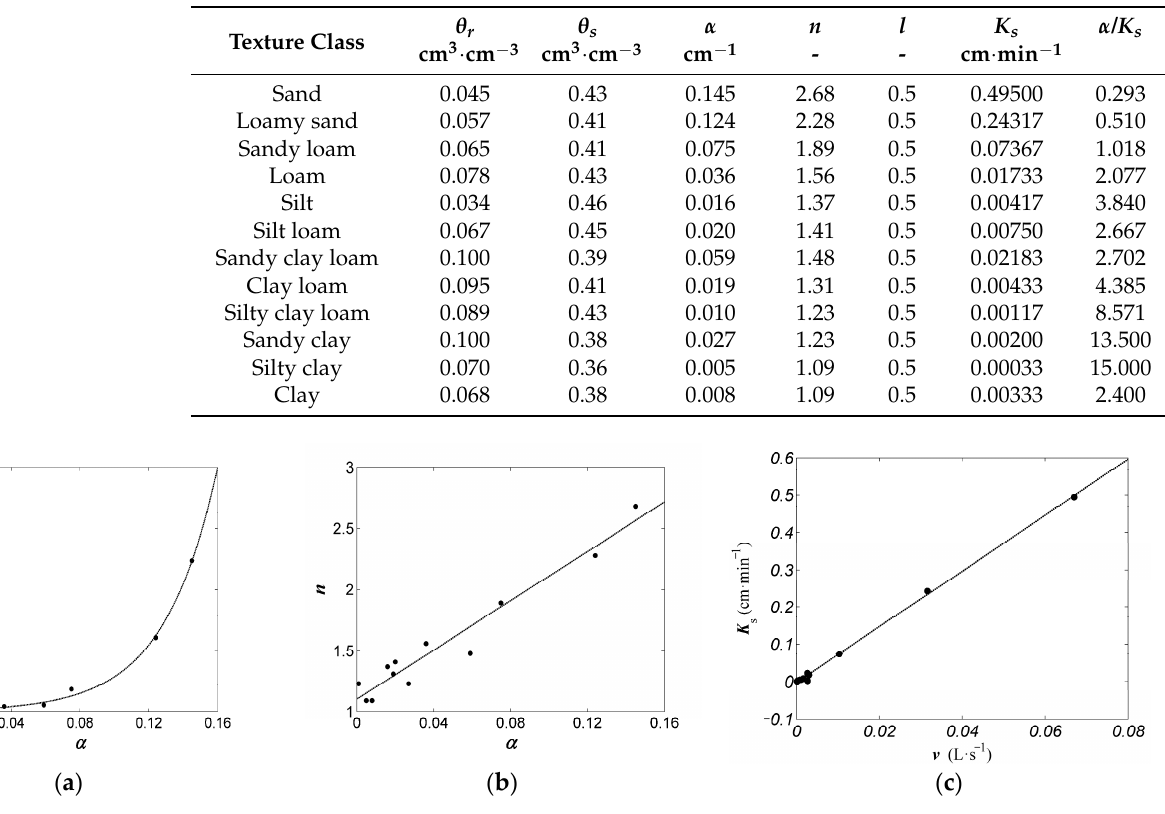
Table 1. Soil hydraulic parameters for the van Genuchten–Mualem model (RETC).